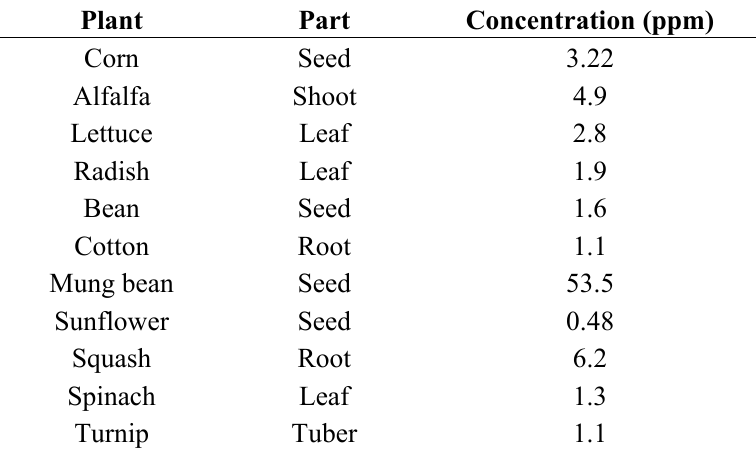
Table 1. Cadmium bioaccumulation in plant parts for a relevant case study south of Tehran, Iran